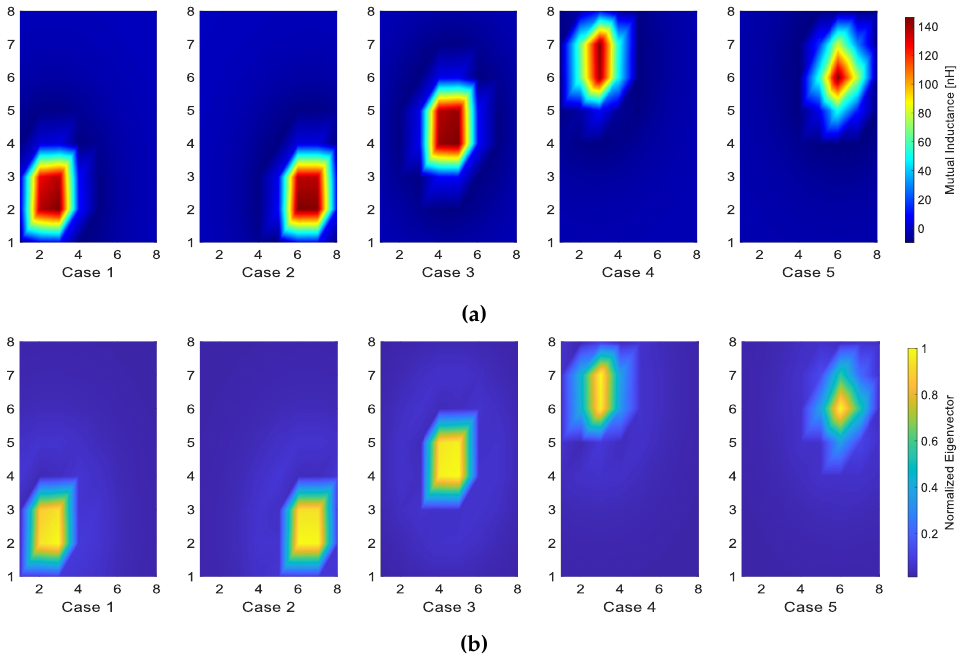
Figure 3. Comparison result of eigenvector and mutual inductance distribution when there is only